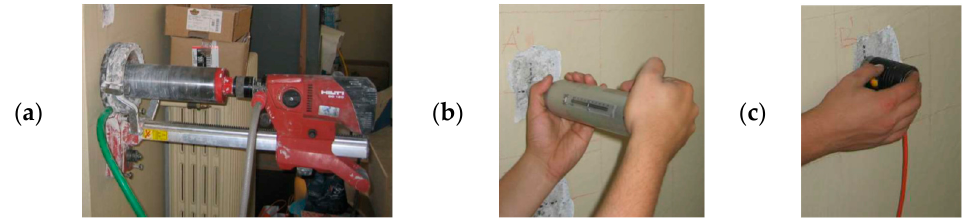
Figure 7. Images of a concrete core drilling ( a ), a sclerometer test ( b ), and an ultrasonic test ( c ). The results of the tests highlighted the average values of yielding and ultimate stress values, f sy and f su , of 380 MPa and 500 MPa, respectively, and Young’s modulus, E s , of 204.000 MPa for steel; and the average values of cylindrical compressive strength, f c , equal to 20.3 MPa, Young’s modulus, E c , of 21.500 MPa, and strains at peak stress and at collapse, ε c , and ε cu , equal to 0.00156 and 0.00402, respectively, for concrete.